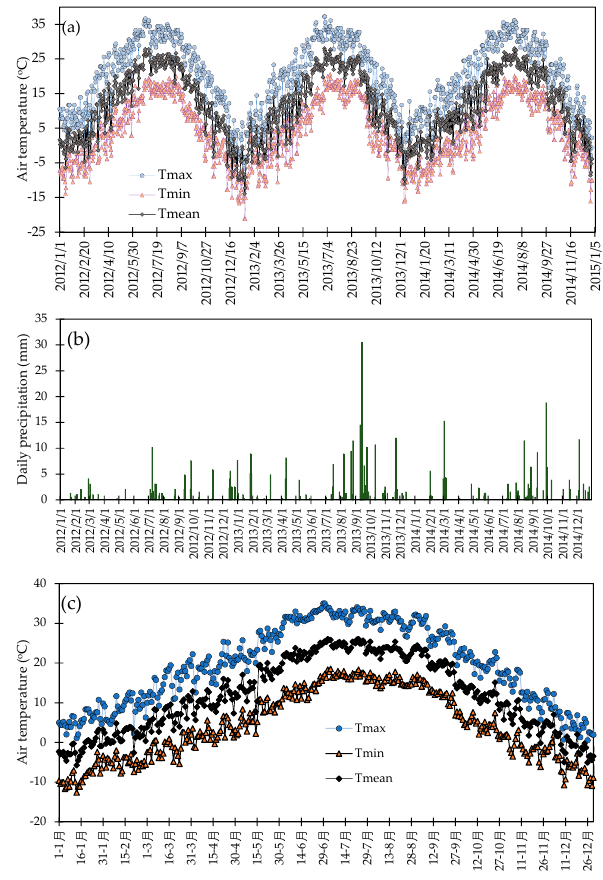
Figure 1 . Evolution of the ( a ) daily maximum (Tmax), minimum (Tmin), and mean (Tmean) air temperatures, ( b ) precipitation during the 2012–2014 period, and ( c ) the 2012–2014 average daily maximum, minimum, and mean air temperatures, and daily precipitation.